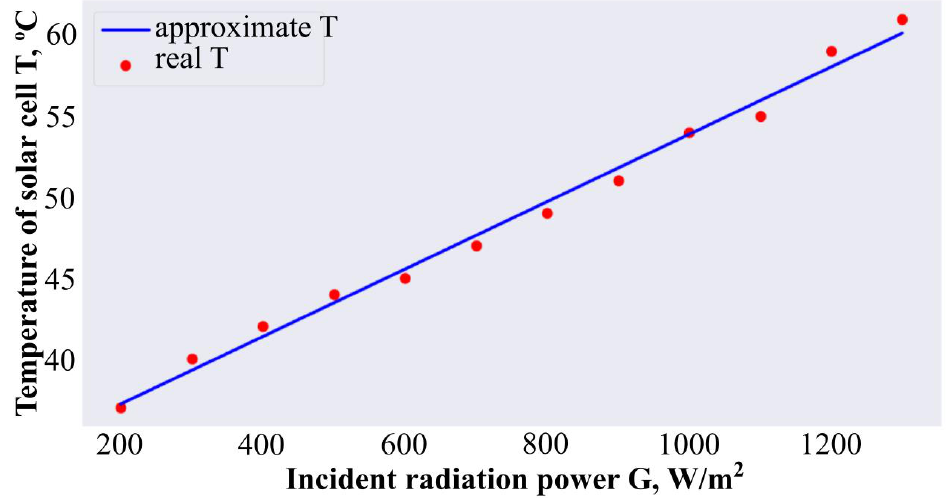
Figure 13. Dependence of the final heating temperature of the solar cell on the incident radiation power.